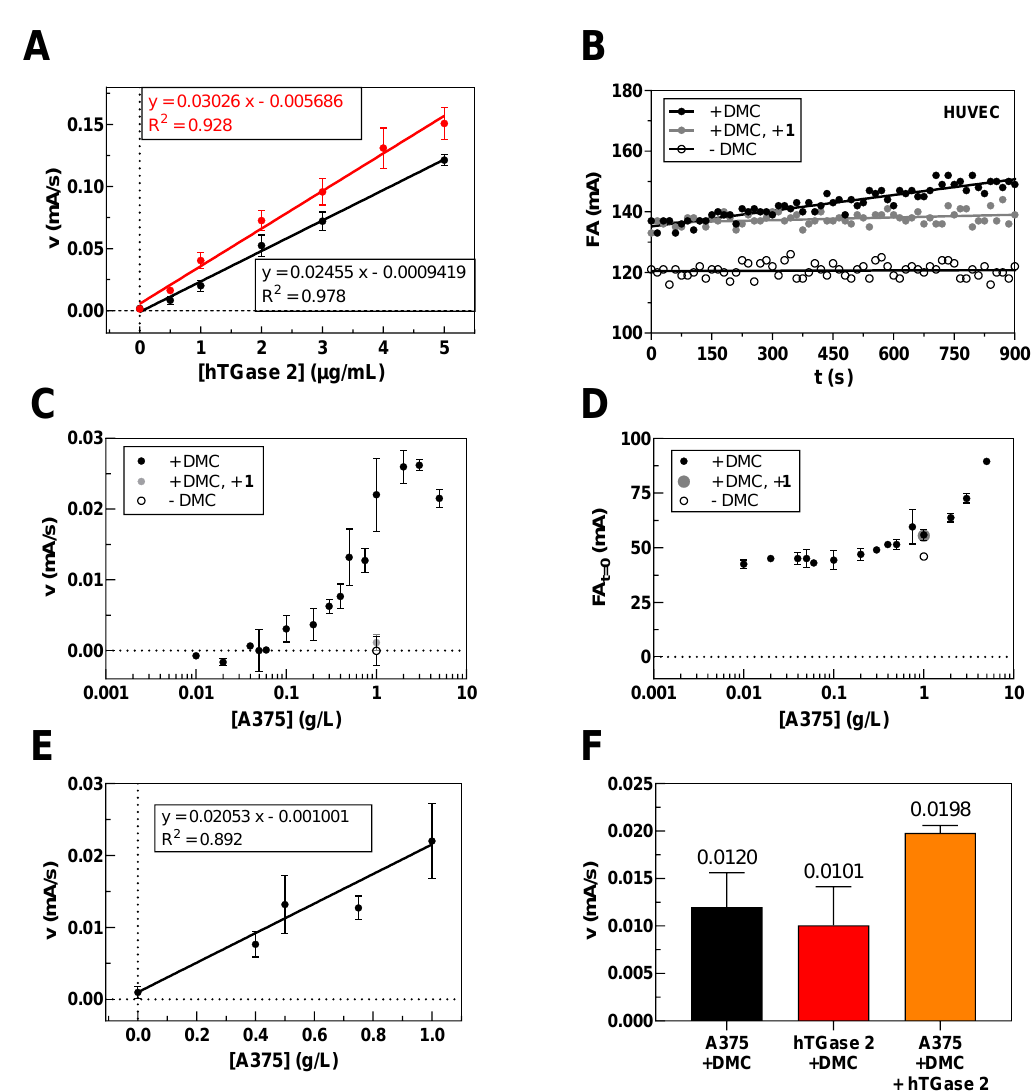
Figure 3. Assessing the accuracy of the FA-based assay to determine the TGase 2 activity in cell lysates. ( A ) Plot of rate versus concentration of recombinant hTGase 2 in MOPS buffer (red) and in a 1:1 mixture of modified RIPA and MOPS buffers (black) with linear regression to the data. Data shown are mean values ± SEM of two separate experiments, each performed in duplicate. Slopes are not significantly different (unpaired t test, p = 0.189 two-tailed). ( B ) Exemplary plot of FA over time for the reaction of R-I-Cad in the presence of HUVEC lysate (0.5 g protein/l) with linear regression to the data to obtain rate values for the FA increase (v in mA/s). To prove that the FA increase over time mainly originates from the activity of TGase 2, control measurements in the presence of the selective TGase 2 inhibitor 1 were performed. Moreover, the necessity of adding DMC as acyl donor to achieve a measurable FA increase was shown by control measurements in the absence of DMC. Data shown are single measurements. ( C ) Plot of rate versus concentration of A375 lysate (0 – 5 g/L). Data shown are mean values ± SD of 2 – 6 measurements. ( D ) Plot of the FA values at start of measurement versus concentration of A375 lysate for the same data set as in ( B ). ( E ) Plot of rate versus concentration A375 lysate (0, 0.4 – 1.0 g/L) with linear regression to the data. ( F ) Results of a “spike and recovery” experiment. hTGase 2 (0.5 µg/mL) was spiked to A375 lysate (0.5 g/L, orange) and the observed rate in FA increase is compared to the rates observed for A375 lysate (black) and hTGase 2 (red) alone. Data shown are mean values ± SD of 2 – 6 measurements. Conditions: pH 8.0, 30 °C, 2.7 mM CaCl 2 , 5% DMSO, 500 µM DTT (cell lysates) or TCEP (recombinant hTGase 2), 30 µM DMC, 0.81 µM R-I-Cad , and 10 µM 1 (preincubation period: 10 min).